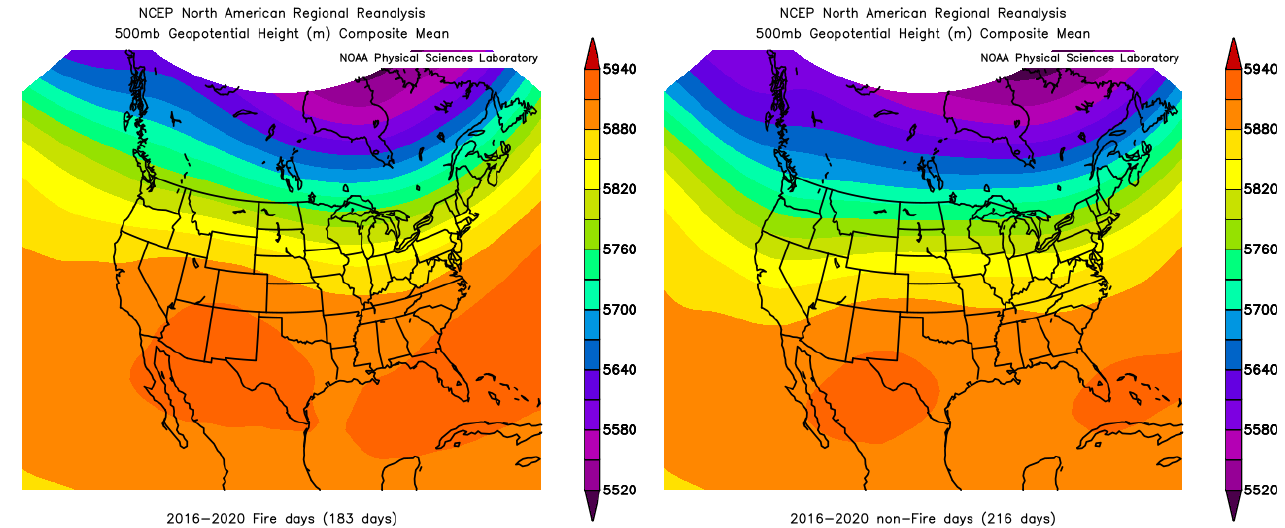
Figure B5. The composite means of 500mb geopotential height for wildfire days (left) and background days (right) during summer 2016– 2020 (NOAA Physical Sciences Laboratory, https://psl.noaa.gov/cgi-bin/data/getpage.pl, last access: 20 April 2022).